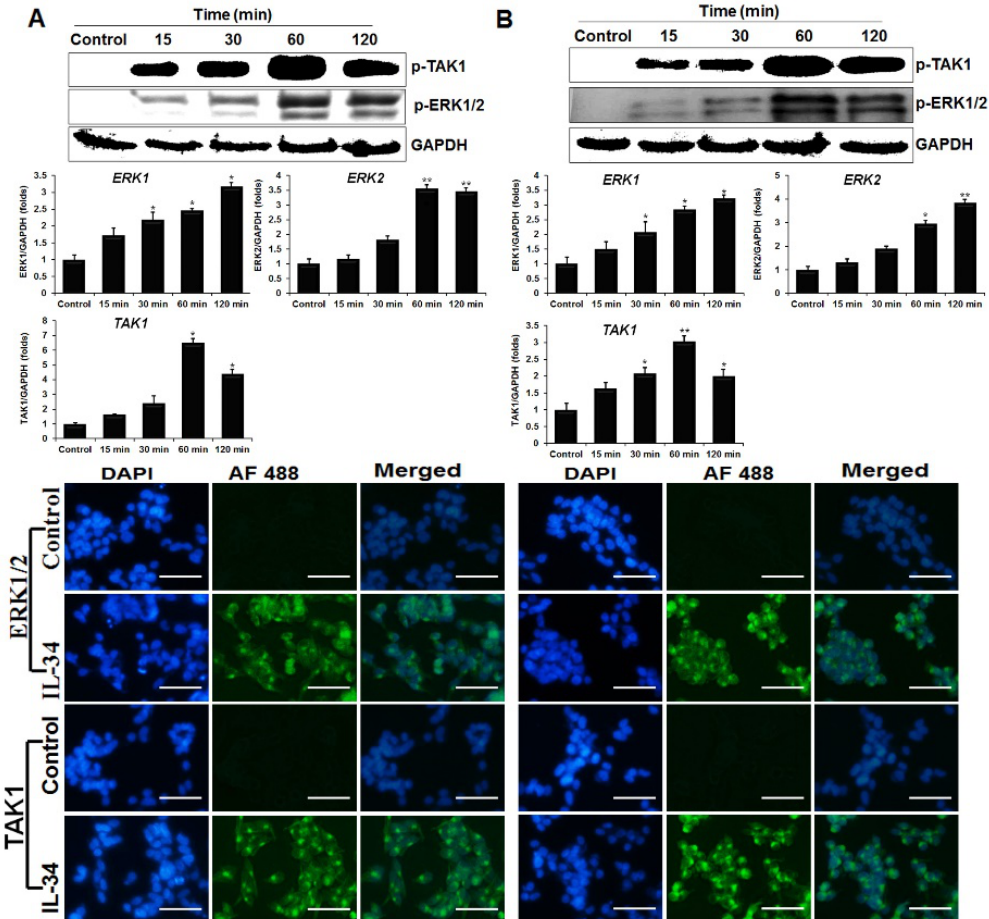
Figure 3. IL-34 induces phosphorylation of extracellular signal-regulated kinase 1 and 2 (ERK1/2) and p-mitogen-activated protein kinase kinase kinase 7 (TAK1). The HD11 ( A ) and OU2 ( B ) cell lines were treated with or without IL-34 for 15, 30, 60, and 120 min. Total lysates were analyzed by western blot with antibodies against p-ERK1/2 and p-TAK1 (top). The changes in mRNA levels for ERK1/2 and TAK1 in cells treated with or without IL-34 were analyzed by qRT-PCR in chicken cell lines and levels were normalized to those of GAPDH (middle). Data are presented as the mean ± SEM ( n = 3) of 3 independent experiments: * p < 0.05 and ** p < 0.01. Immunocytochemical analysis of p-ERK1/2 and p-TAK1 signaling proteins in HD11 (left) and OU2 (right) cells. Untreated cells and those treated with chIL-34 were incubated with primary antibody, Alexa Fluor ® 488-conjugated goat anti-rabbit IgG (H + L) secondary antibody, and DAPI (blue). Scale bar represents 25 µm.